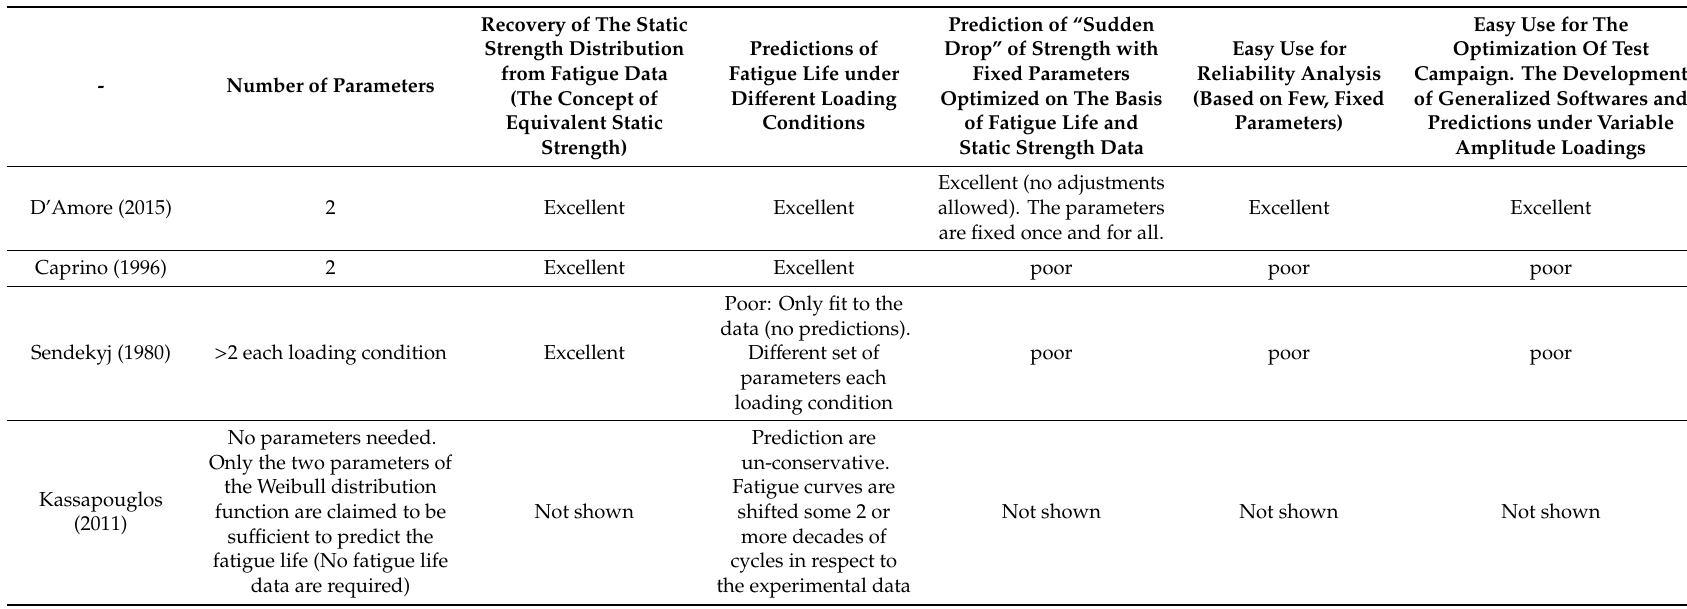
Table 2. Comparative capabilities of the relevant models.